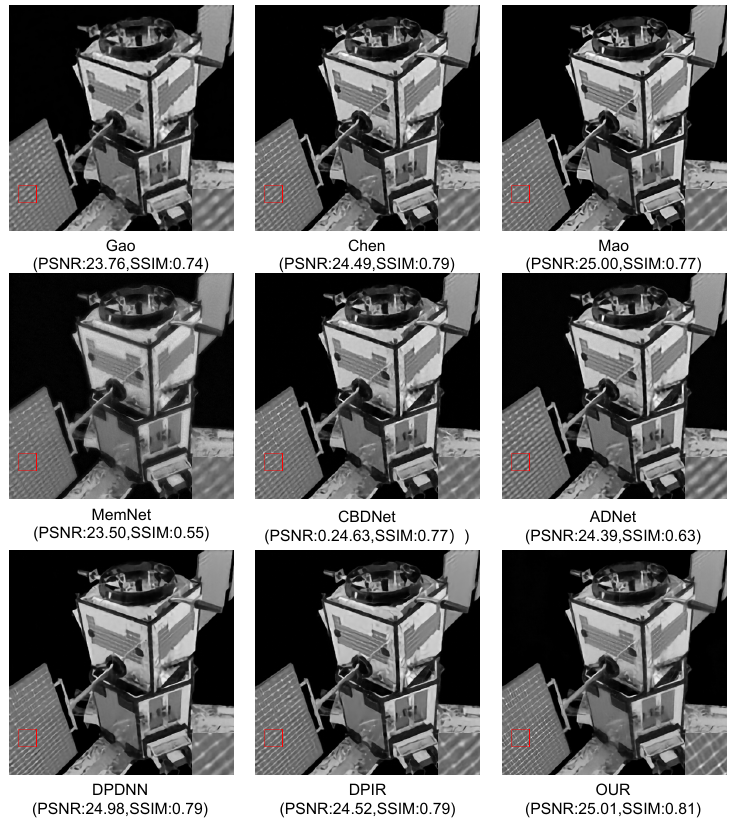
Figure 13. Restoration using different methods on severe turbulence blur (The red boxes represent the focus region). Table 5. Average PSNR and SSIM of different state-of-the-art methods on severe degradation (The best results are shown in bold